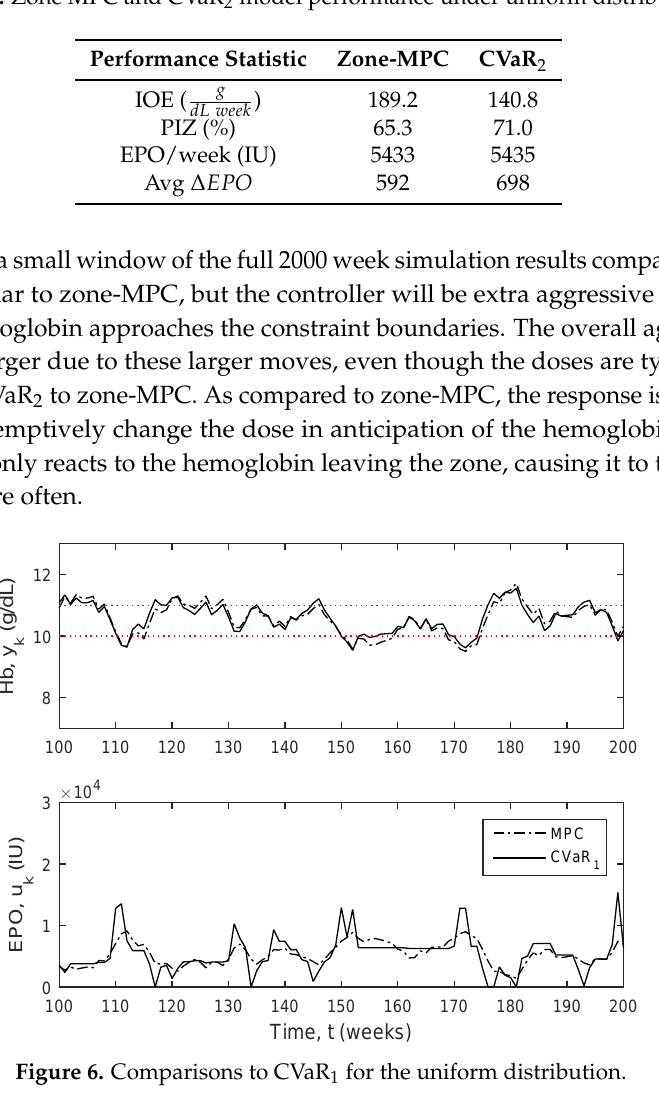
Table 4. Zone MPC and CVaR 2 model performance under uniform distribution.